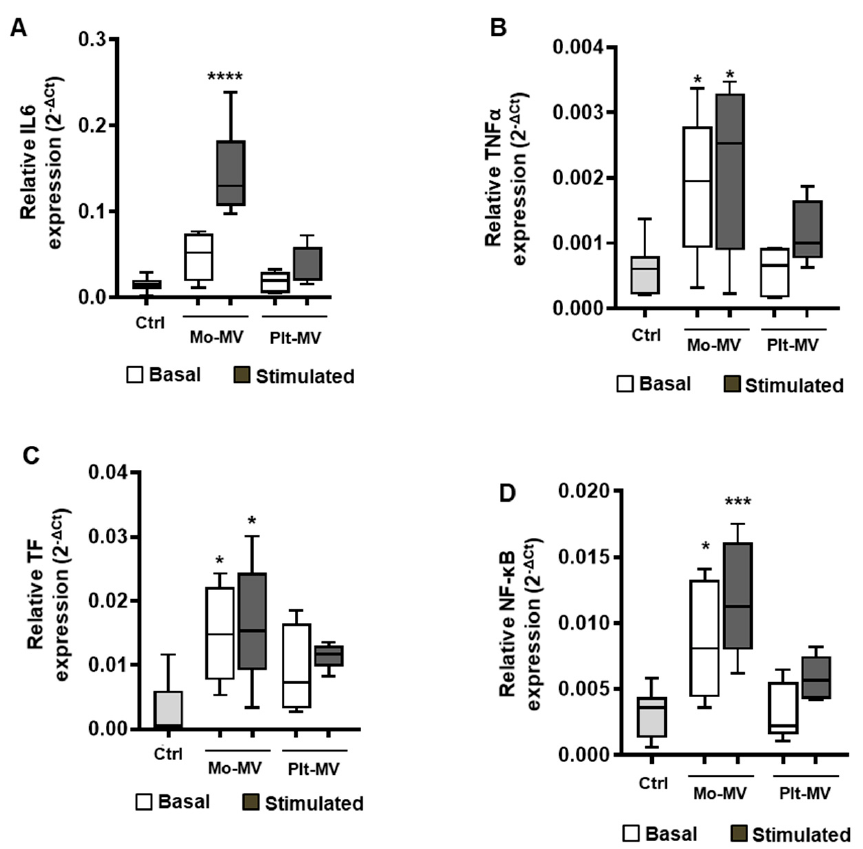
Figure 3. Mo- and Plt-MV effect on inflammation markers’ expression in human endothelial cells. hECV were stimulated for 6 h with MVs released from monocytes ( n = 8) and platelets ( n = 10) isolated from healthy subjects, under resting conditions (basal) or upon stimulation with LPS (10 µ g/mL) or TRAP-6 (20 µ M), respectively. Gene expression analysis for IL-6 ( A ), TNF α ( B ), TF ( C ), and NF- κ B ( D ) was performed. Data are represented in box and whisker plot (min to max) and analyzed by one-way ANOVA with Dunnett’s test for multiple comparisons (TNF α ), or Kruskall–Wallis with Dunn’s test for multiple comparisons (other genes). * p < 0.05; *** p < 0.001; **** p < 0.0001 vs. untreated cells (Ctrl). Overall, these data highlight the capacity of monocyte-derived MVs to regulate the endothelial inflammatory pathway, this occurring both with MV released from unstimu- lated or stimulated cells. In contrast, the endothelial inflammatory response is only slightly influenced by platelet-derived